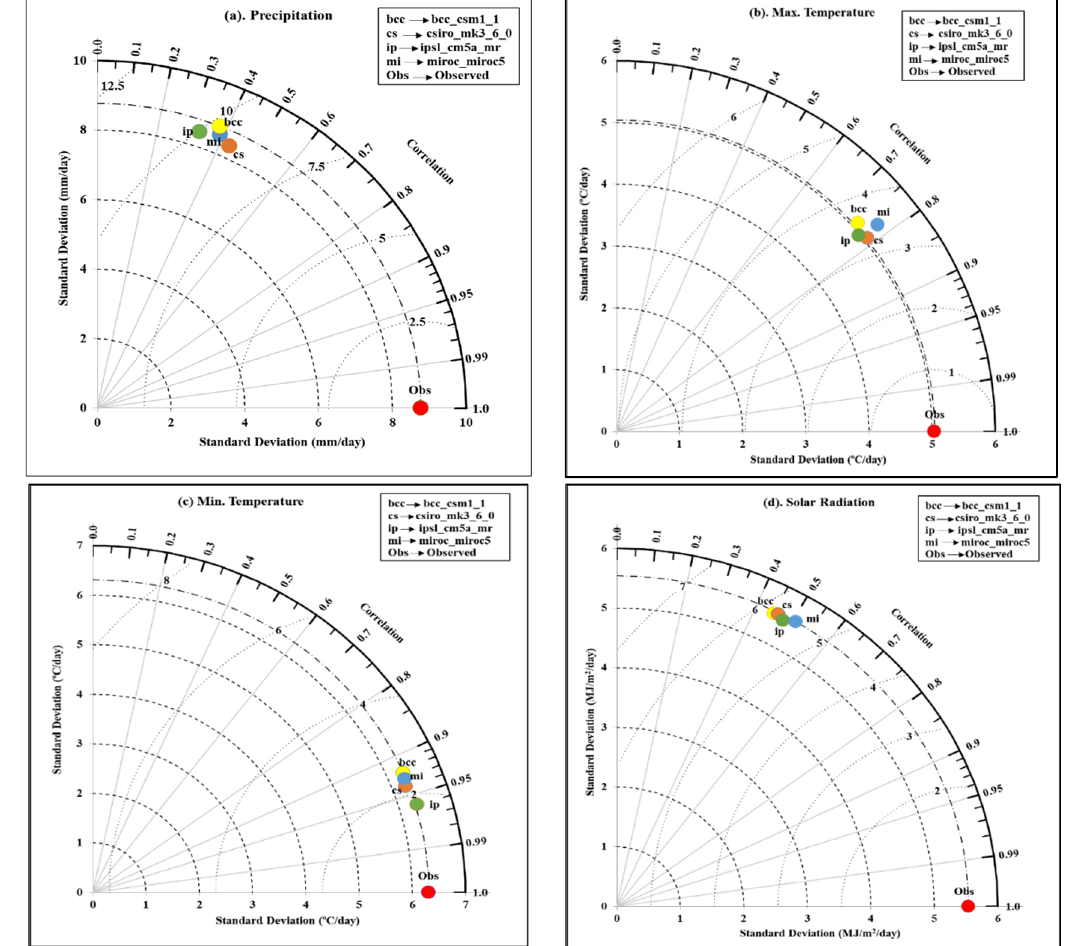
Figure 5. Taylor diagram exhibiting statistical comparisons of observation and four global climate models predicted data for ( a ) precipitation, ( b ) maximum temperature, ( c ) minimum temperature, and ( d ) solar radiation.